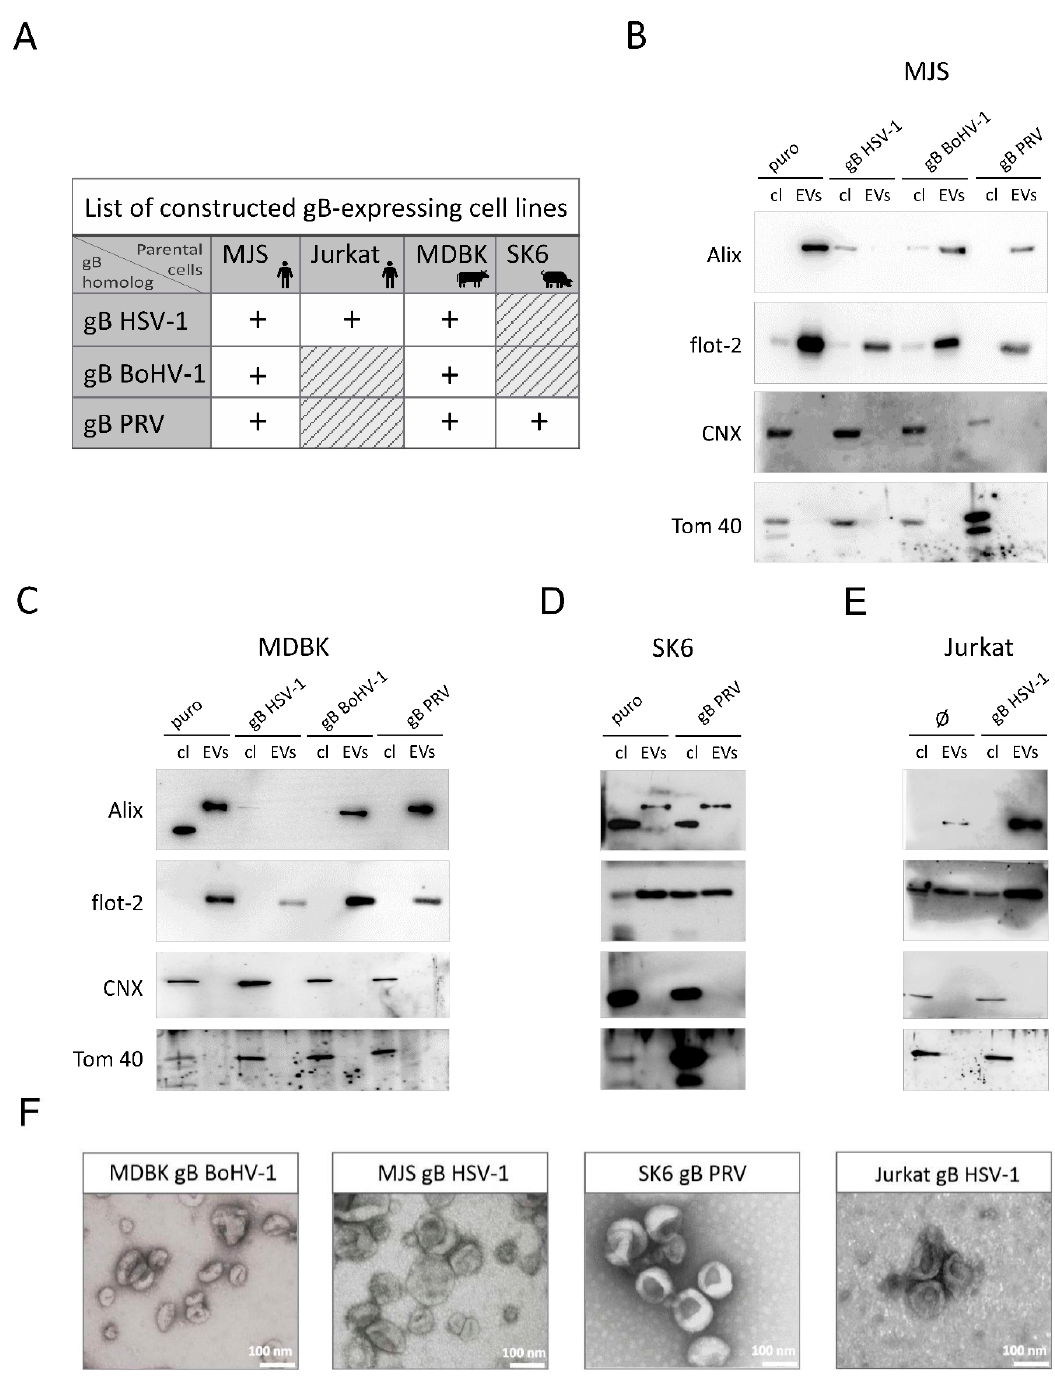
Figure 1. Construction of stable cell lines expressing bovine herpesvirus 1 (BoHV-1), pseudorabies virus (PRV), or herpes simplex 1 (HSV-1) glycoprotein B (gB), and characterization of size exclusion chromatography (SEC)-isolated extracellular vesicles (EVs). ( A ) The list of constructed cell lines expressing individual viral gB homologs. Human melanoma Mel JuSo (MJS) and Madin–Darby bovine kidney (MDBK) produce endogenous major histocompatibility (MHC) class II. The Human Jurkat T cell line and swine kidney SK6 cells are MHC II-negative. ( B – E ) Immunoblotting detection of EVs markers Alix and flotillin-2 (flot-2) in cell lysates (cl) of constructed cell lines or SEC-isolated EVs. Calnexin (CNX) and mitochondrial Tom 40 were used as non-EVs control proteins. MJSpuro, MDBKpuro, SK6puro, or untransduced Jurkat cells (Ø) were used as negative controls. ( F ) Representative transmission electron microscopy images of EVs preparations from gB-expressing species-specific cells; scale bar 100